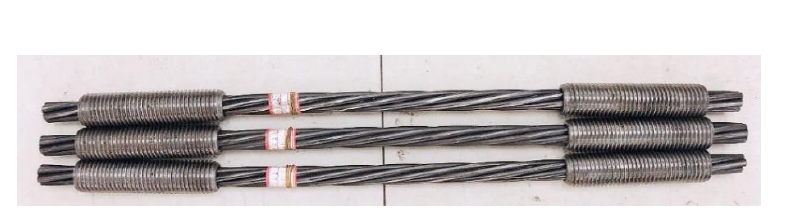
Figure 4. Sample of flexible bolt.